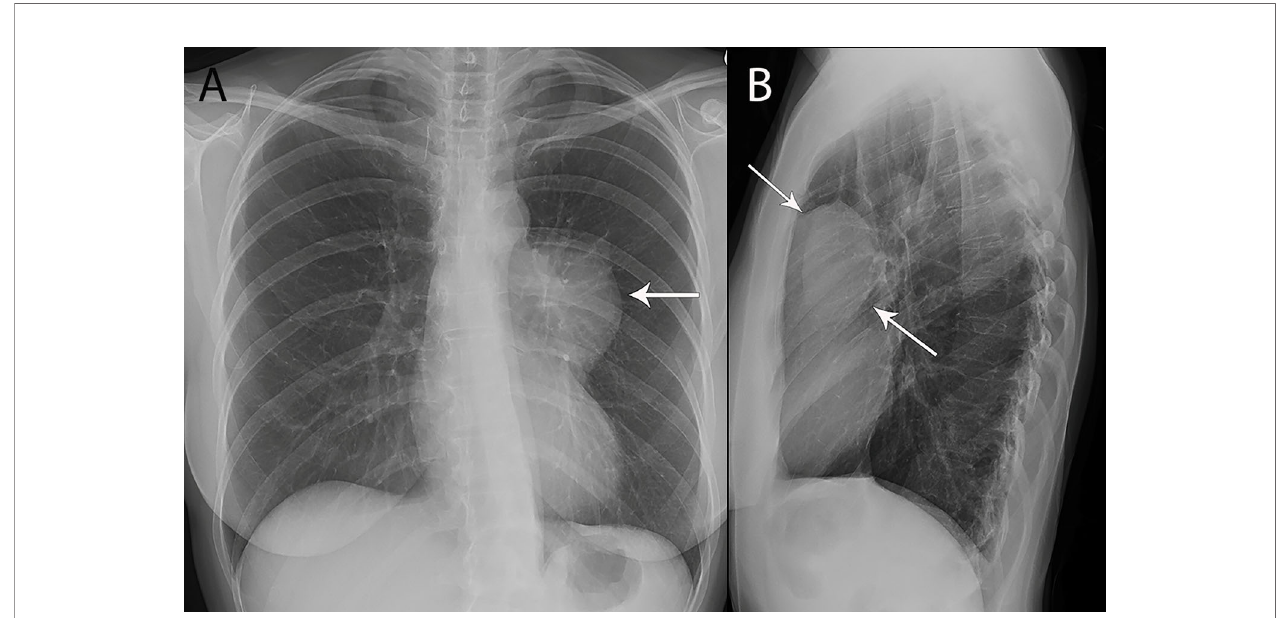
FIGURE 1 | 53 year old woman with thymoma. (A, B) Frontal chest radiograph (A) shows left mediastinal contour abnormality (arrow) that results in loss of the silhouette of the upper left heart border. (B) The lesion is localized to the prevascular mediastinum in the retrosternal space (arrows) on the lateral chest radiograph (B)